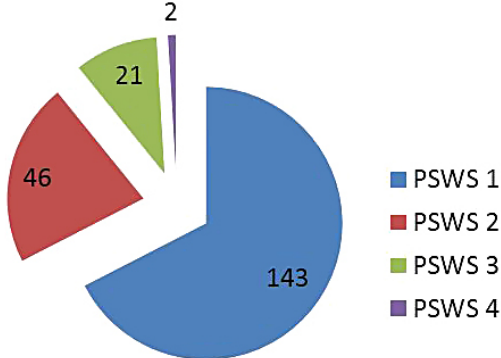
Figure 5. PSWS frequency distribution for Metro Manila.